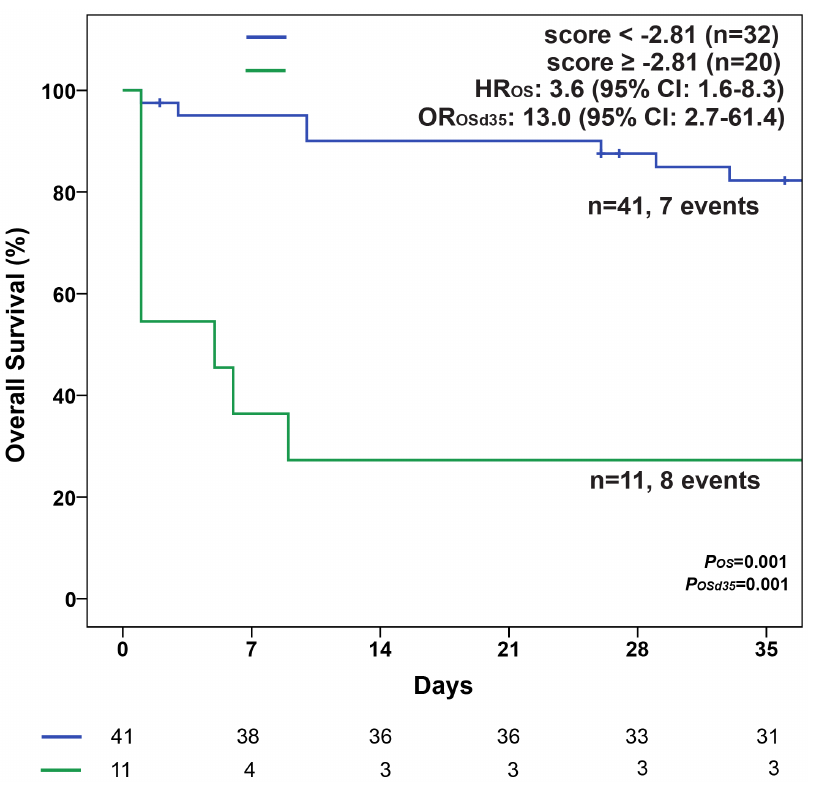
Figure 4. Survival in the first 35 days according to the ED d7 Score. Median OS was 8.8 months (95% CI: 5.4–12.3 months) in patients with a LowR score ( ,2 2.81) and 0.2 months (95% CI: 0.03–0.3 months) in patients with a HiR score ( $2 2.81). Abbreviations: CI, confidence interval; HR, Hazard Ratio; OR d35 , Odds ratio for death until ( # ) day 35; OS, Overall survival. doi:10.1371/journal.pone.0095062.g004 PLOS ONE |